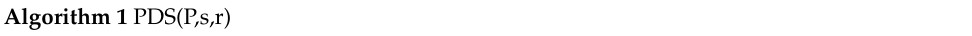
Figure 7. Simplified schematic diagram of point cloud data.